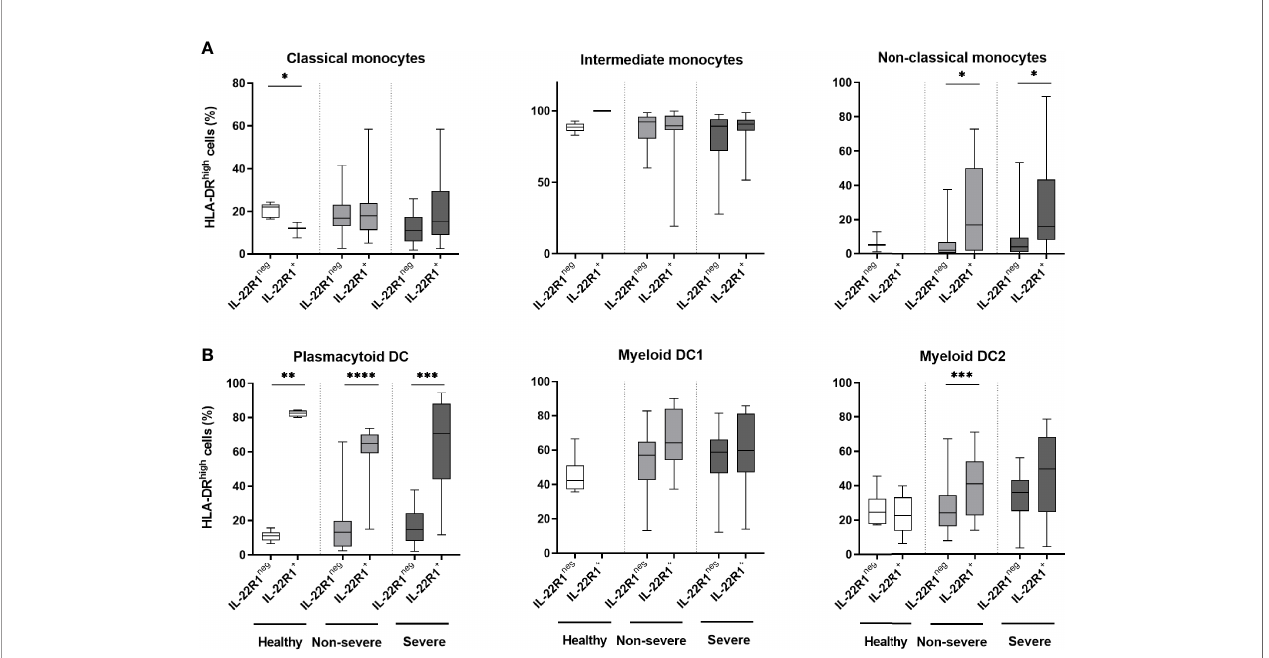
FIGURE 5 | HLA-DR high expression on IL-22R1 + and IL-22R1 - myeloid cell subsets in COVID-19 patients and controls. The percentages of HLA-DR high expression on IL-22R1 + and IL-22R1 - cells at Day 0 are represented for (A) monocyte subsets and (B) DC subsets, in healthy controls (n=6), non-severe (n=19) and severe (n=14) COVID-19 patients. The boxes show the 25-75% interquartile ranges, horizontal bars indicate the medians and vertical bars indicate the minimum and maximum of the results within each column. The signi fi cant p values are indicated on the graphs as * p <0.05, ** p <0.01, *** p <0.001 and **** p <0.0001 (Mann Whitney U